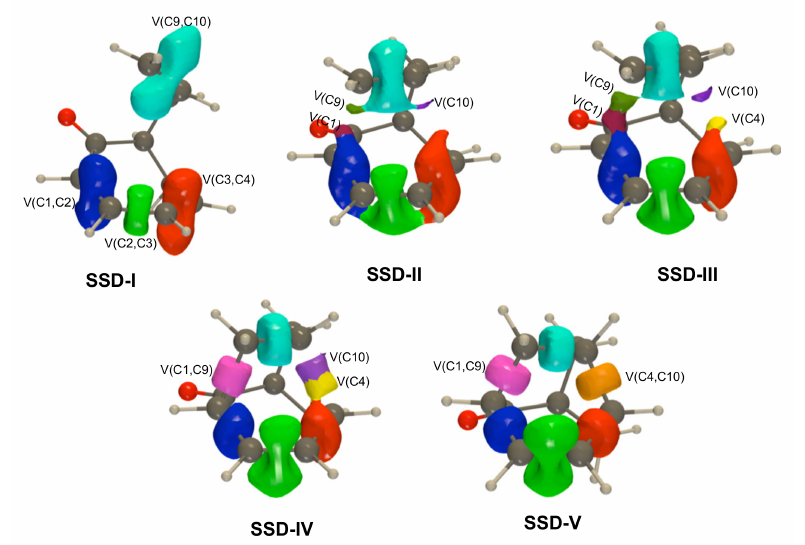
Figure 4. ELF basin isosurfaces ( η = 0.7) of each of the SSDs found along the IRC associated with TS2-a . Color labeling of the basins is adopted according to Figure